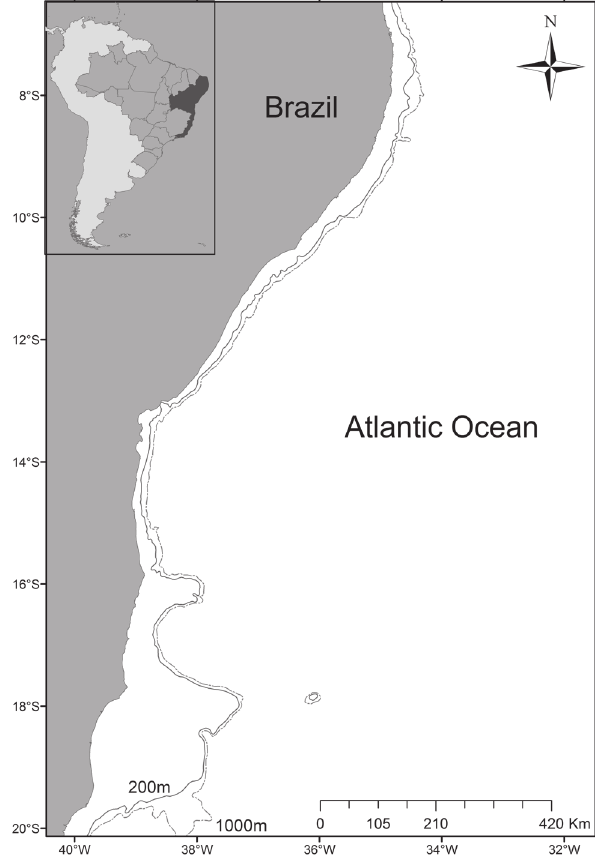
Figure 1. Northeastern coast off Brazil at breeding ground where humpback whales were satellite instrumented between 2003 and 2008. The light gray lines represent the 200 and 1000m